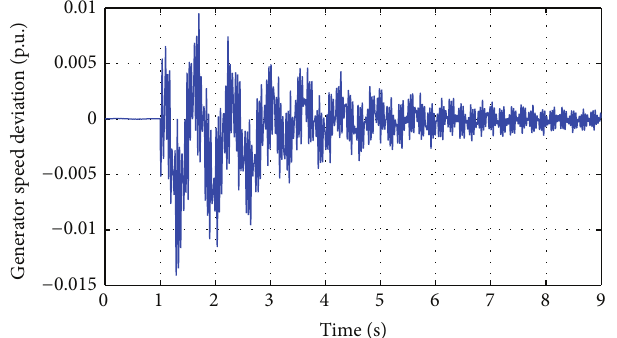
Figure 12: Curve of SVC’s firing